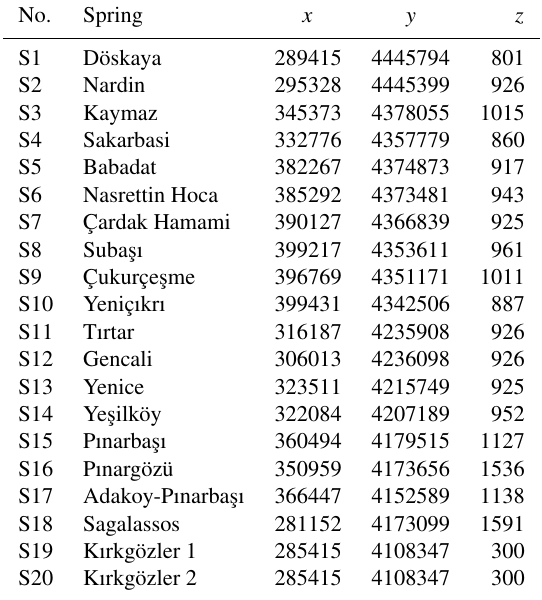
Table 1. Location of